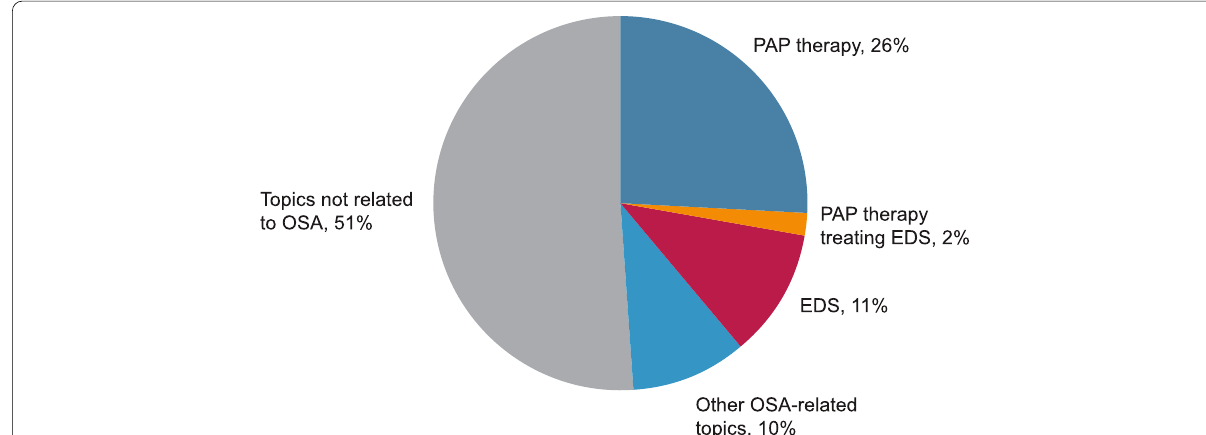
Fig. 2 Average percentage of visit discussion dedicated to key topics. Notes: Visit discussion among all participants, including physicians, patients, visit companions, and other healthcare professionals, if applicable. PAP Therapy: Discussion of PAP therapy (eg, Physician: “And how do you feel like you’re doing with your [CPAP] machine?”); PAP Therapy Treating EDS: Discussion of PAP therapy in the context of treating EDS (eg, Physician: “Did the use of the [CPAP] machine make you feel better during the day? Did you have more energy? Were you less sleepy?”); EDS: Discussion of EDS